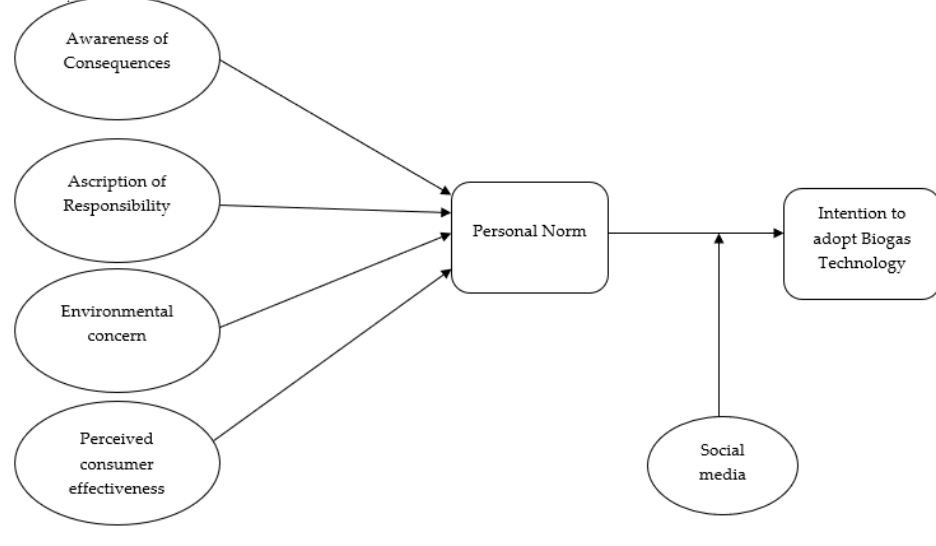
Figure 1. Conceptual framework.